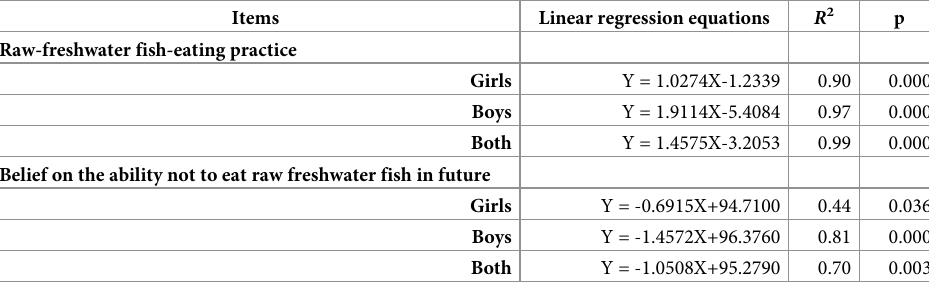
Table 1. Changing trends of practice and belief by ages of students. Items Linear regression equations R 2 p Raw-freshwater fish-eating practice Girls Y = 1.0274X-1.2339 0.90 0.000 Boys Y = 1.9114X-5.4084 0.97 0.000 Both Y = 1.4575X-3.2053 0.99 0.000 Girls Y = -0.6915X+94.7100 0.44 0.036 Boys Y = -1.4572X+96.3760 0.81 0.000 Both Y = -1.0508X+95.2790 0.70